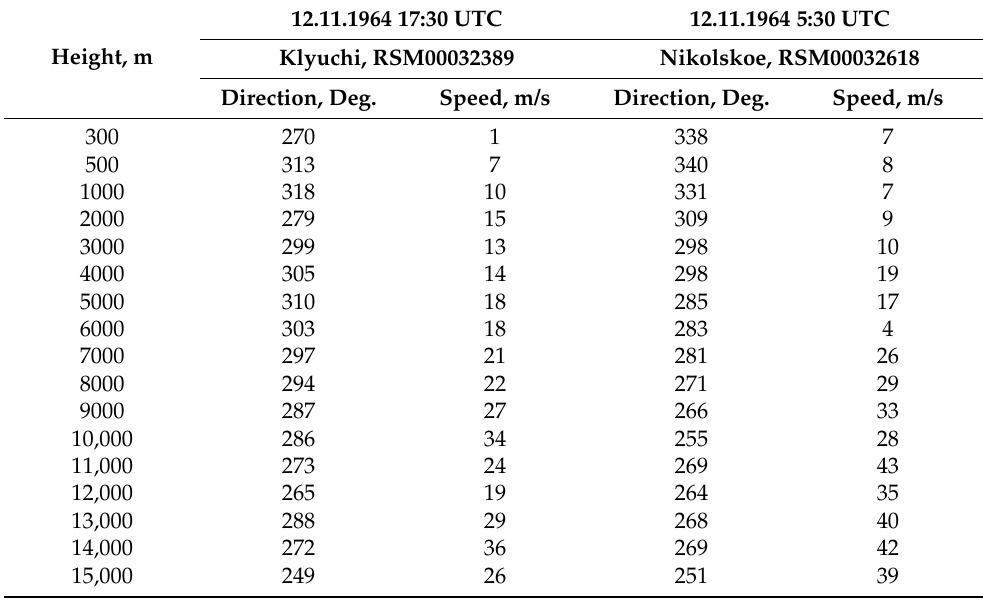
Table 2. Wind speed and direction during Sheveluch volcano eruption in 1964 according to [6].